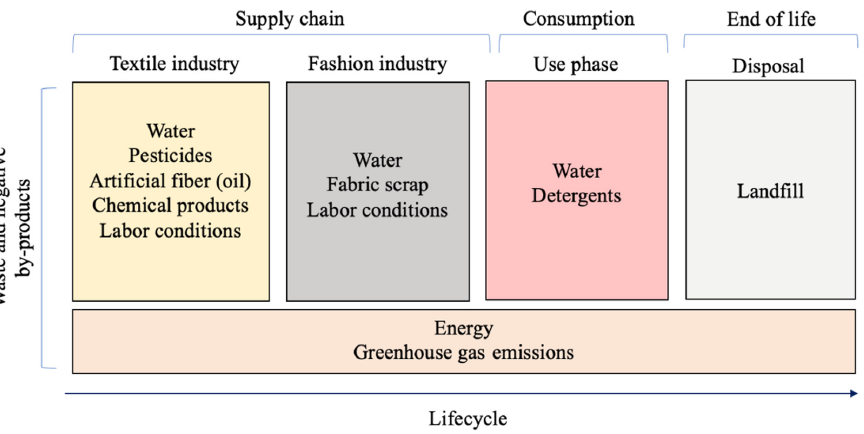
Figure 1. Environmental and social impacts of the textile and fashion industries [33,84,85].